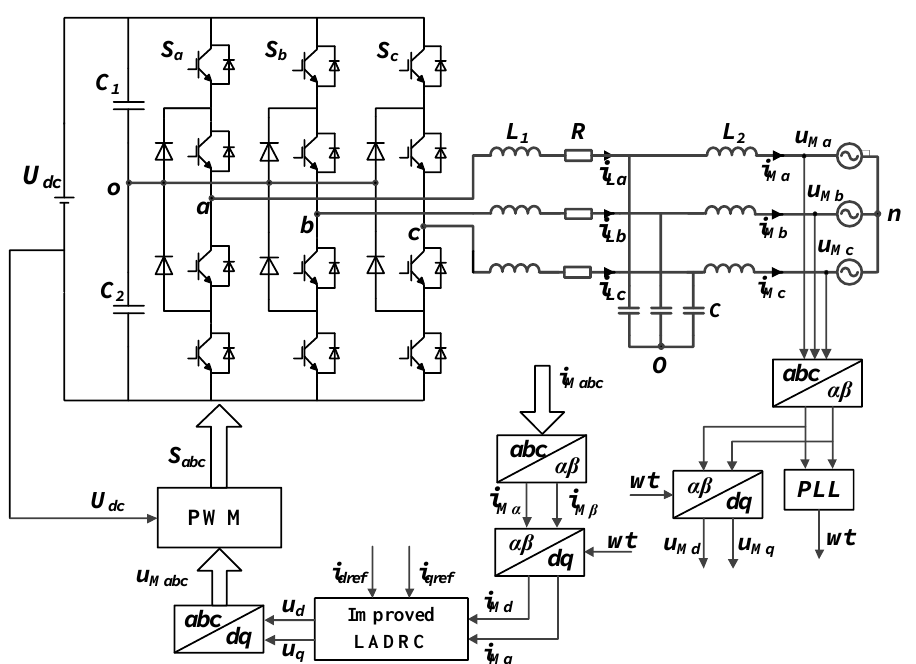
Figure 1. LCL grid-connected inverter topology.